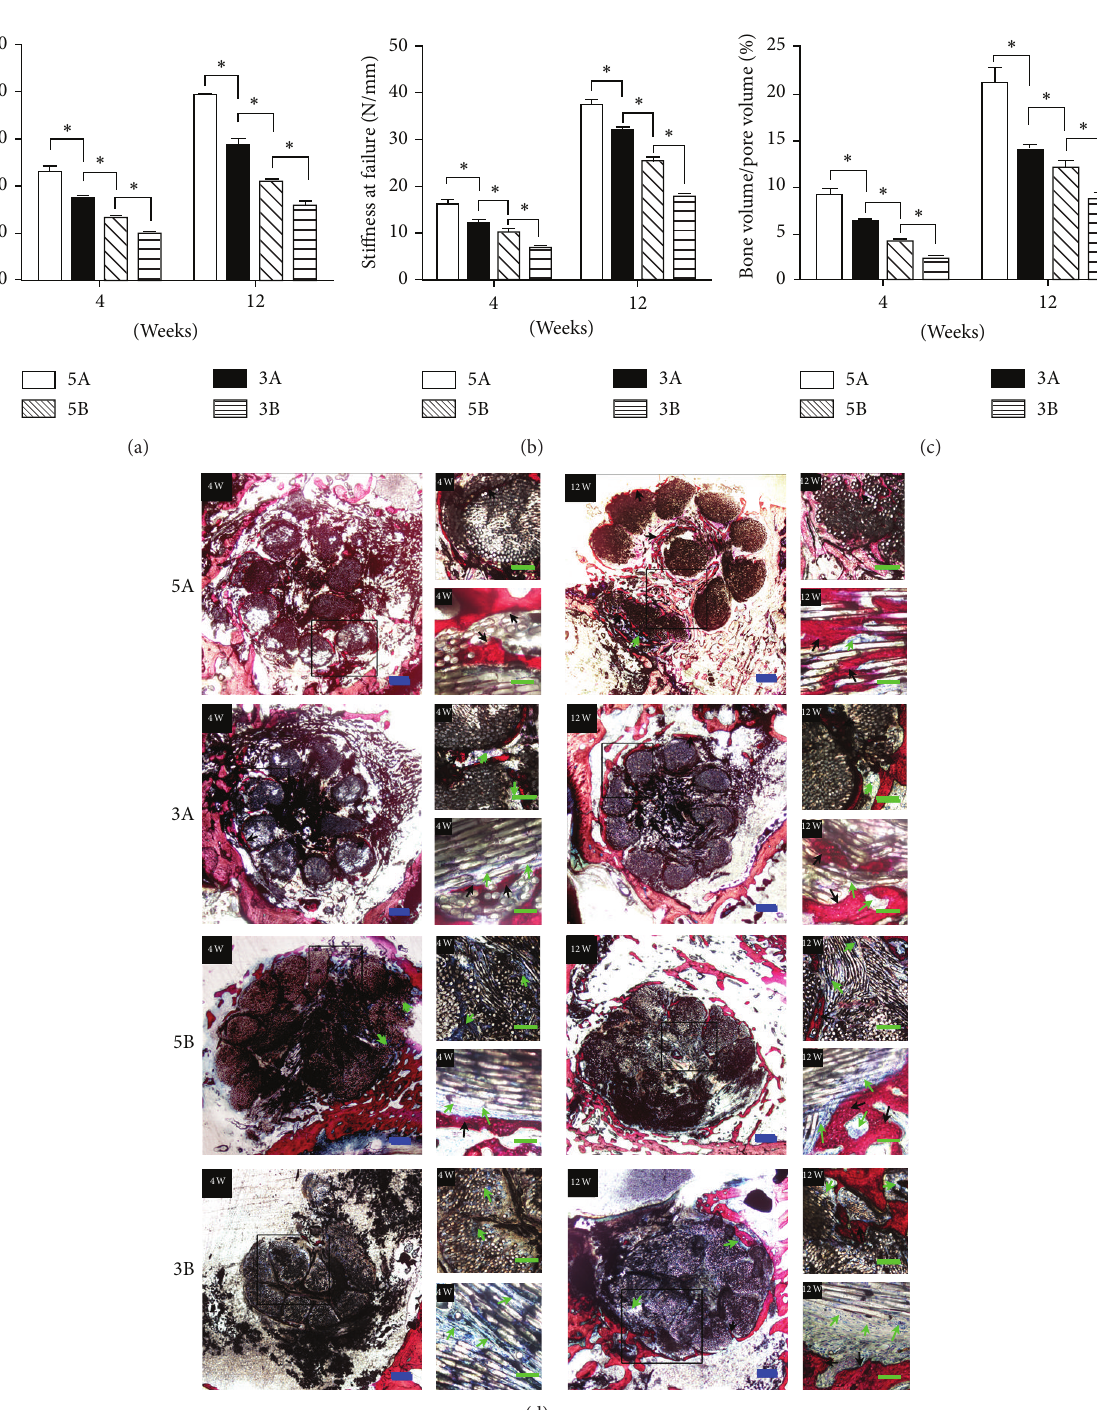
Figure 5: (a) The ultimate failure load of each group at 4- and 12-week time points. (b) The stiffness of each group at 4- and 12-week time points. (c) Histomorphometric analysis of new bone formation within each kind of implant. (d) The light microscope images of pathological sections of each kind of group. High-resolution microscope VG staining images of pathological sections to the longitudinal axis showed the details of graft-to-bone interface. The newly formed bone was stained red and fibrous tissue was stained dark blue. The black arrows indicate newly formed bone and the green arrows indicate fibrous tissue. ∗ indicates 𝑝 < 0.05 . Scale bars: 500 𝜇 m (blue) and 200 𝜇 m